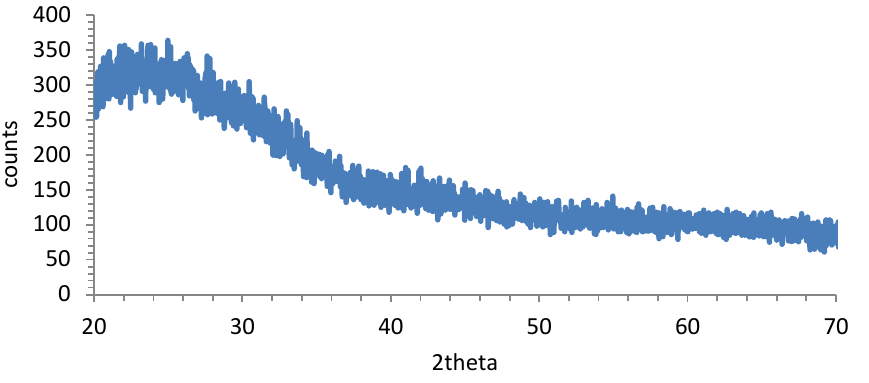
nanocomposite thin 2